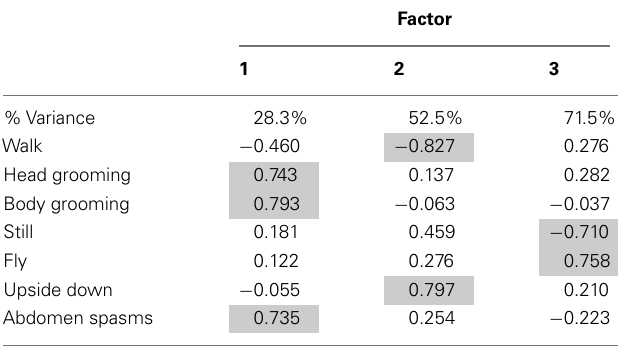
Table 2 | Factor analysis produced from whole behavioral